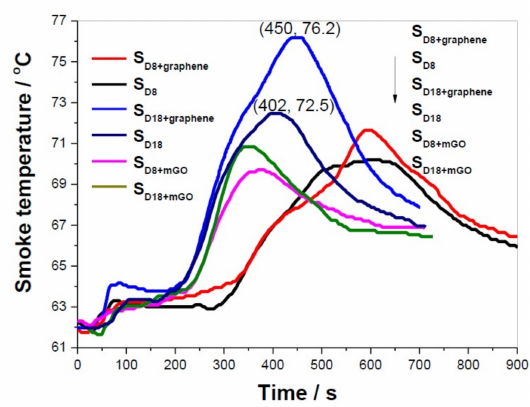
Figure 3. Smoke temperature of exhaust pipe during combustion of